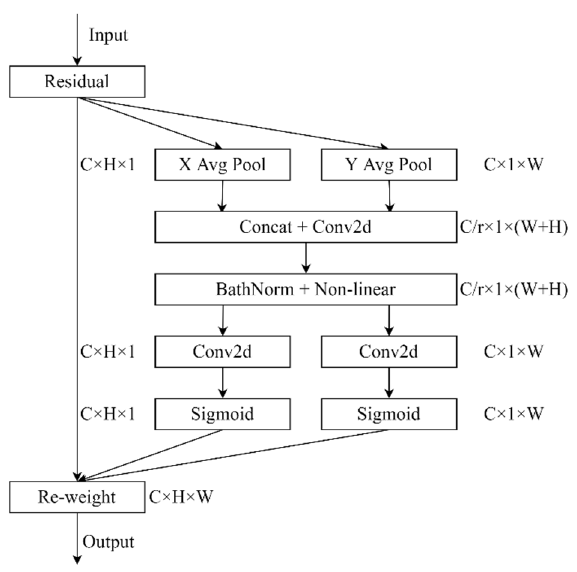
Figure 7. The CA attention mechanism, ‘X Avg Pool’ and ‘Y Avg Pool’ denote 1D horizontal global average pooling and 1D vertical global average pooling.